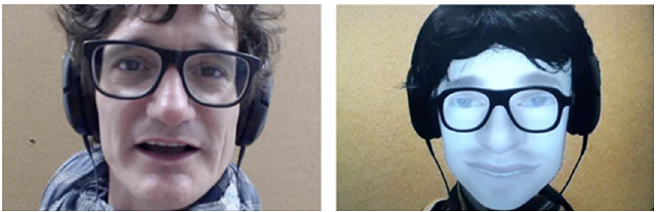
Figure 1. Single frames extracted from the live video feeds projected on a screen visible on a mirror positioned in front of the scanned participants’ eyes, with the Human (left) vs Robot (right) male conversant. Informed consent from participant for publication was